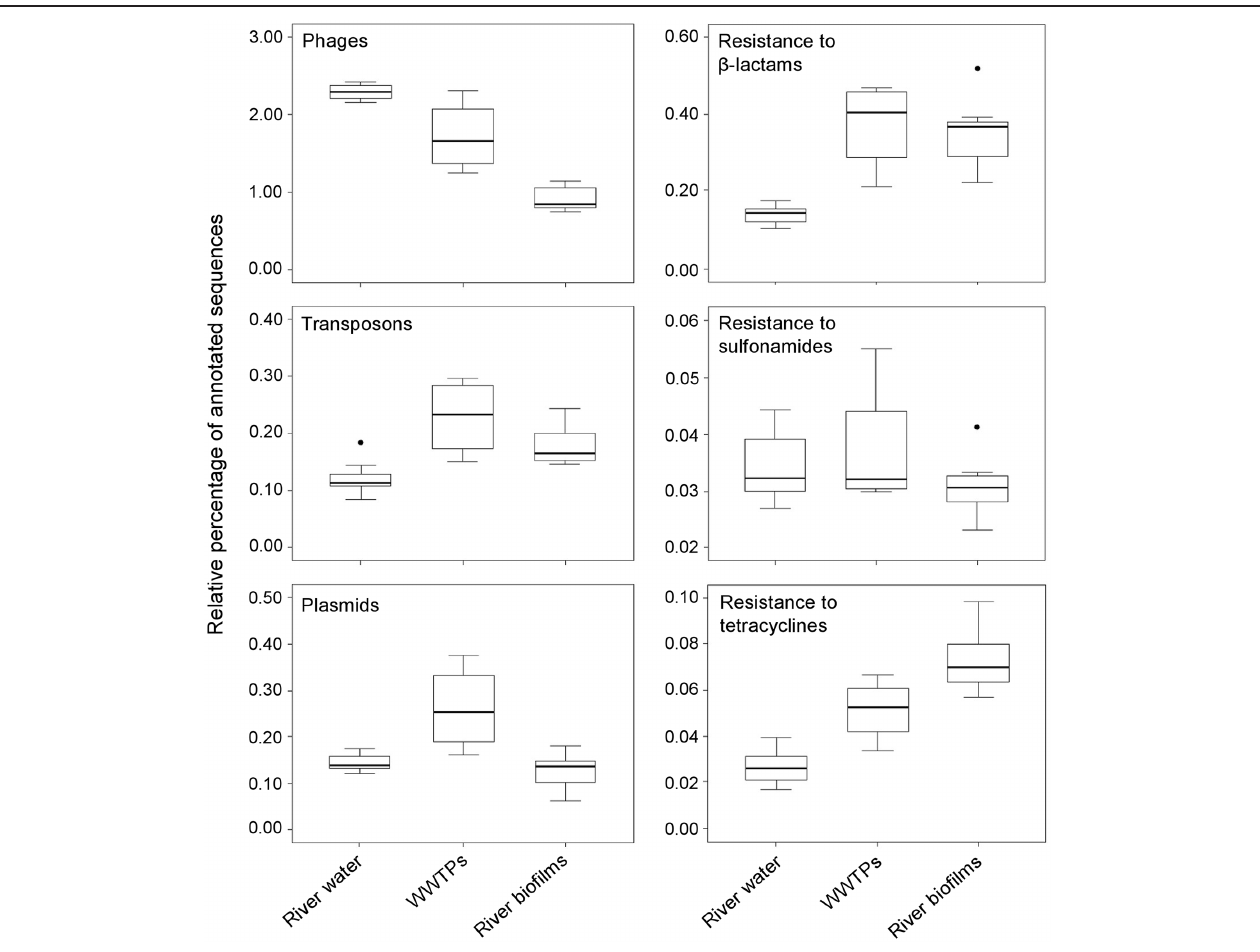
FIGURE 1 | Metagenomic explorationof the resistome from environmental sources. Relative distribution of reads assigned to six functional subsystems among 23 metagenomes (based on MG-RAST annotation, E -value = 10 − 5 ) Data are normalized by the total annotated sequences and are expressed as a percentage. The horizontal line in each box plot represents the mean of the relative distribution in each of the three environments (river water, WWTPs, and river biofilms), and the black circles represent the outliers. The 23 metagenomes used for the analysis are available at http://metagenomics . anl . gov . Accession numbers for river waters: 4511251.3, 4511252.3, 4511253.3, 4511254.3, 4511255.3, 4511256.3, and 4511257.3; WWTPs: 4455295.3, 4463936.3, 4467420.3, and 4511199.3; and river biofilms: 4528142.3, 4528143.3, 4528144.3, 4528145.3, 4528146.3, 4528147.3, 4589537.3, 4589538.3, 4589539.3, 4589540.3, 4589541.3, and